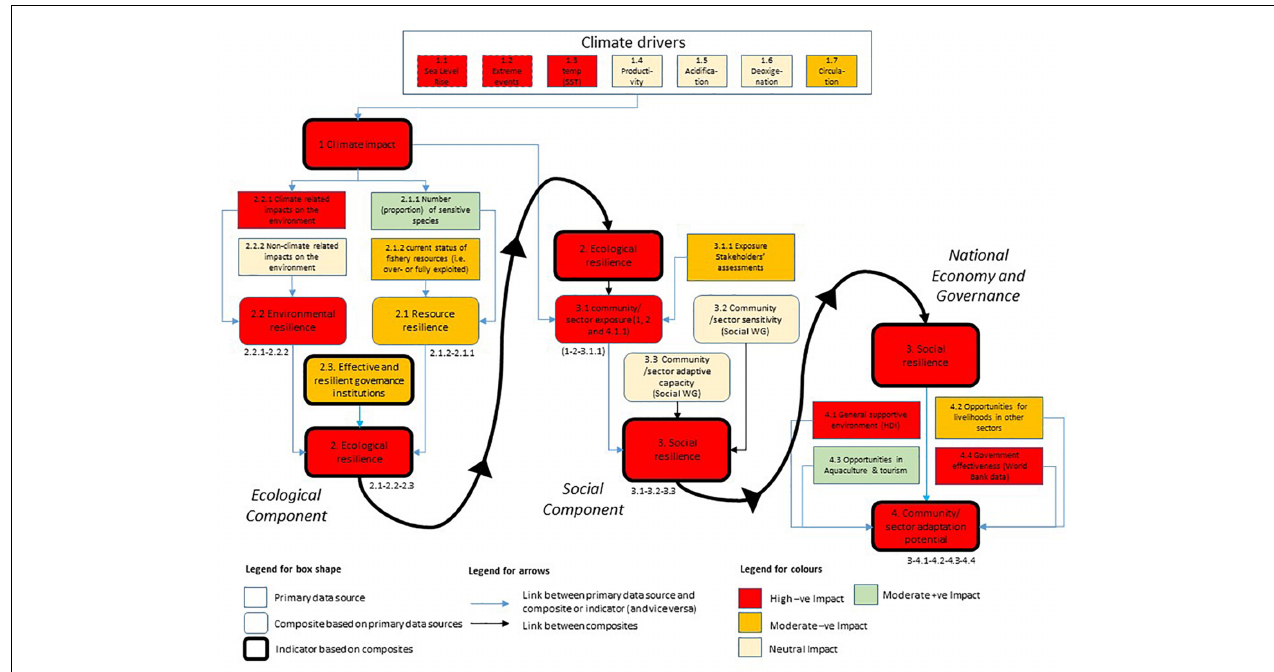
FIGURE 9 | General vulnerability and resilience of fisheries-dependent communities on the north and west coast of Madagascar, determined using the logic rules method for aggregation of scores. See also the alternative method using means ( Supplementary Figure S1 ). HDI, Human Development Index; MDI, Multidimensional Poverty Index (UNDP,